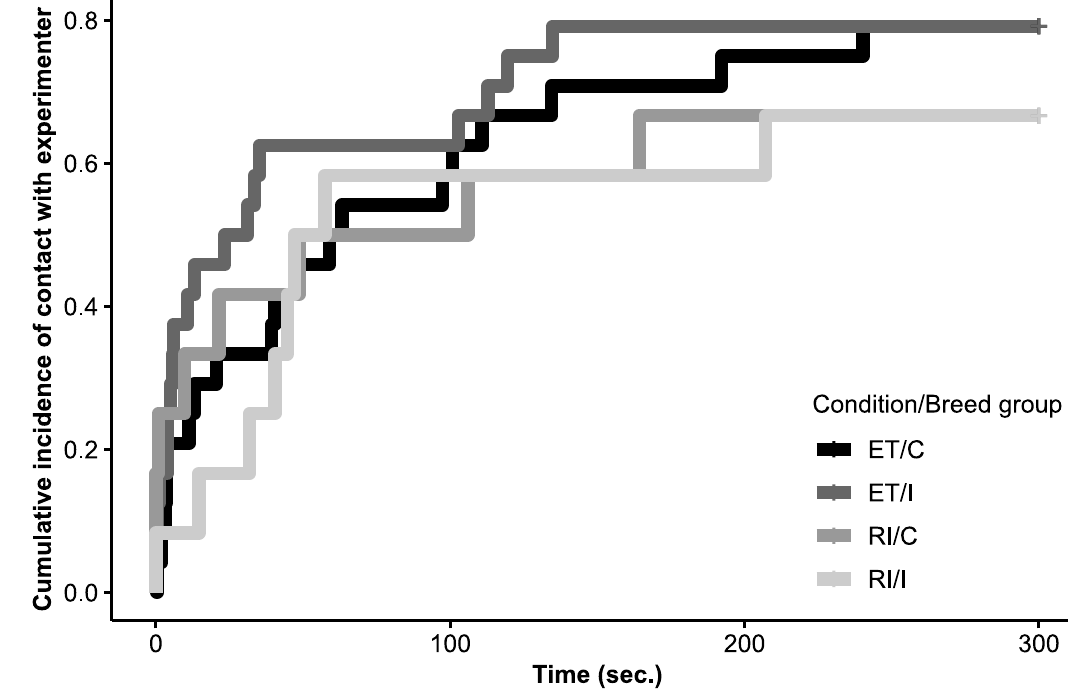
Fig 5. Cumulative incidence of first contact with the experimenter (as proportion of observations) for subjects of cooperative worker (N = 12) and independent worker (N = 12) breeds in the interaction session after both social conditions of the paw task. Derived from Kaplan-Meier estimates. ET, equity; RI, reward inequity; C, cooperative worker breeds; I, independent worker breeds.